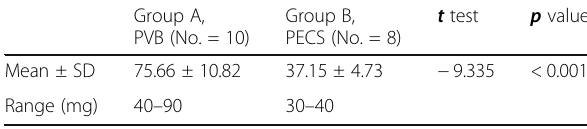
Table 7 Time to first request of analgesia (h) Group A, PVB Group B, PECS t test p value Table 8 Total dose of postoperative pethidine